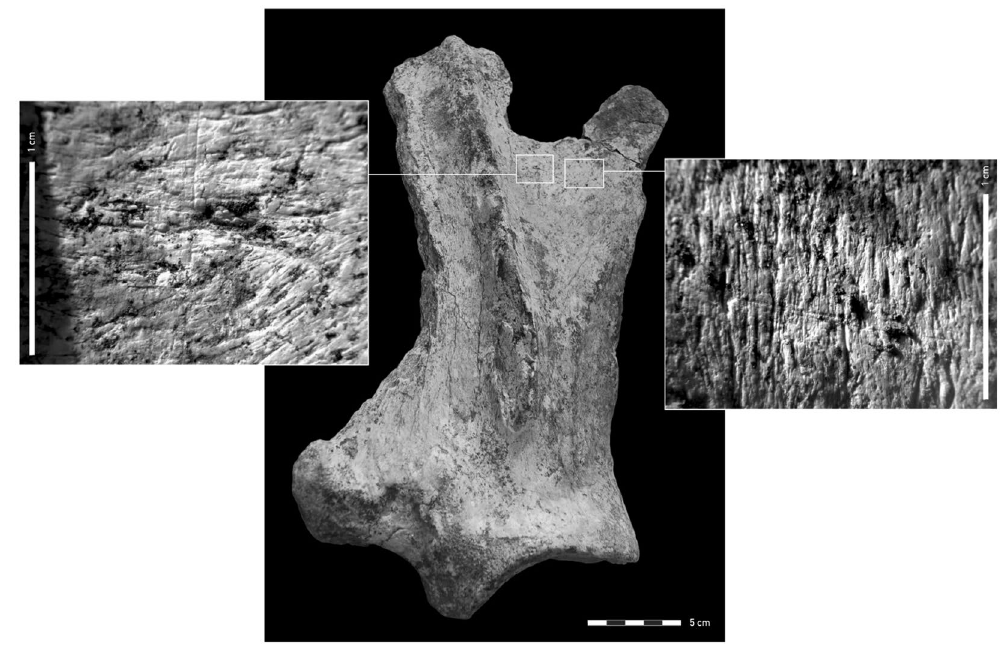
Figure 6. Scapula of Hippopotamus cf. amphibius with cut-marks made by lithic tools during butchering ( right insert ). Left insert : The cut-mark is superimposed by a carnivore tooth-mark, probably a scavenging